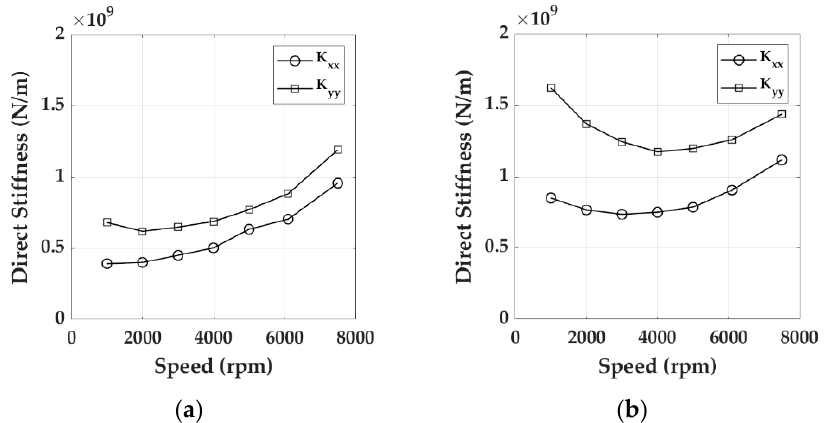
Figure 27. Direct Lube Rocker Pivot bearing synchronous direct stiffness: ( a ) 0.8 MPa, ( b ) 1.7 MPa.